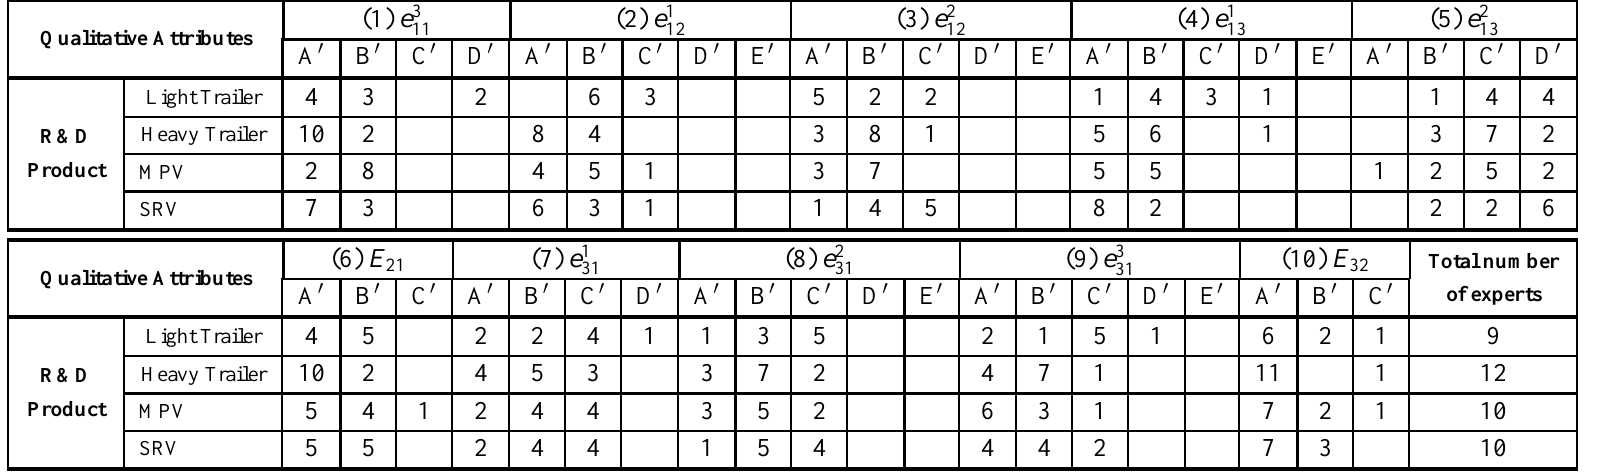
Table 11. The Original assessment of R&D project in qualitative